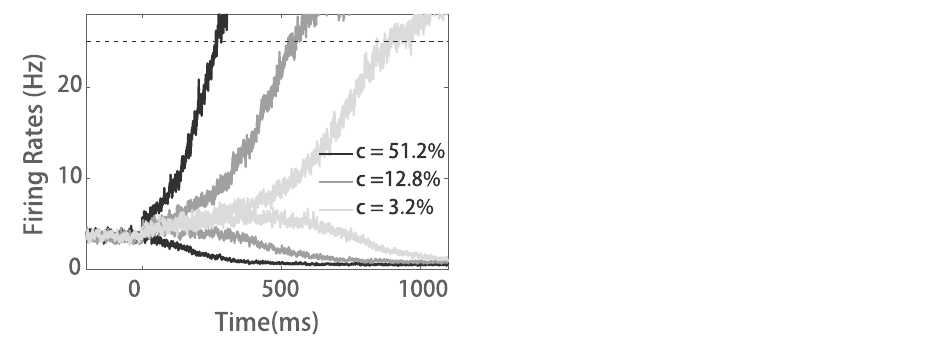
Figure 2. Ramping activities of the neurons in the decision layer during decision making. The dashed line indicates the decision